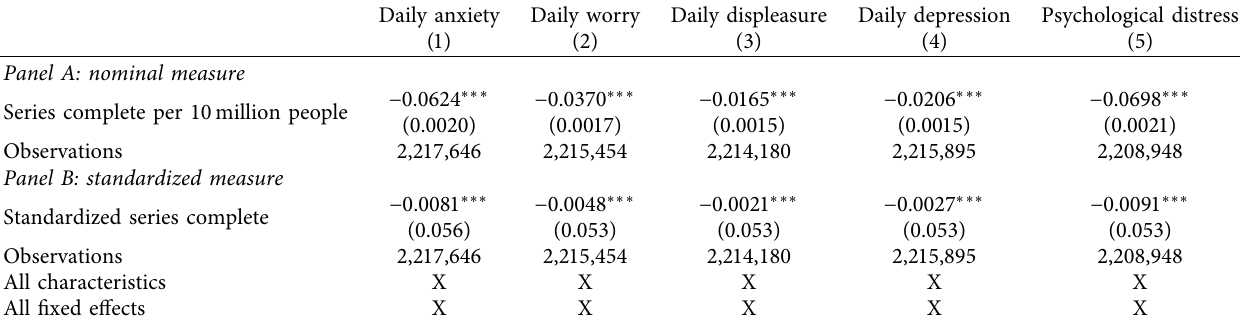
Table 7: Vaccination and mental health—other explanatory measures.